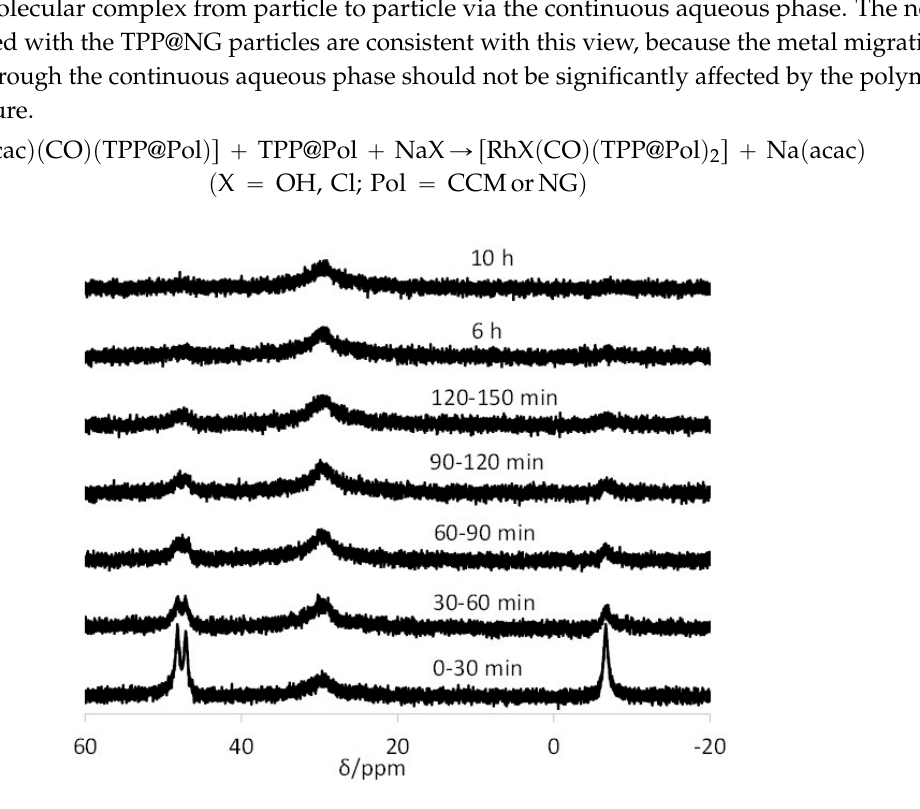
Figure 7. 31 P{ 1 H} NMR spectra of the latex obtained by mixing equimolar amounts of TPP@NG and [Rh(acac)(CO)(TPP@NG)] at pH 13.6. The data for each spectrum were collected for 30 min; the time intervals for data collection from the time of mixing are indicated on each spectrum.